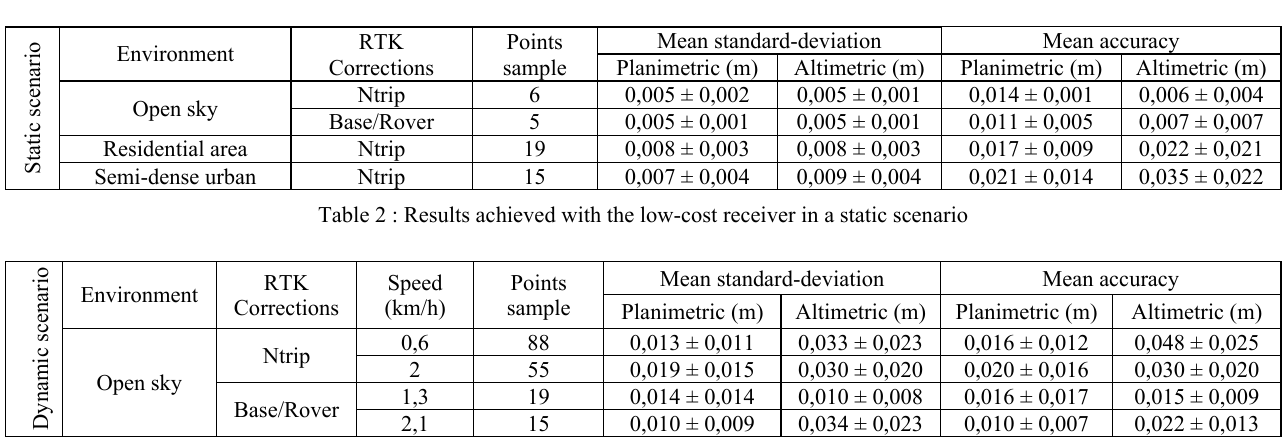
Table 3 : Results achieved with the low-cost receiver in a dynamic